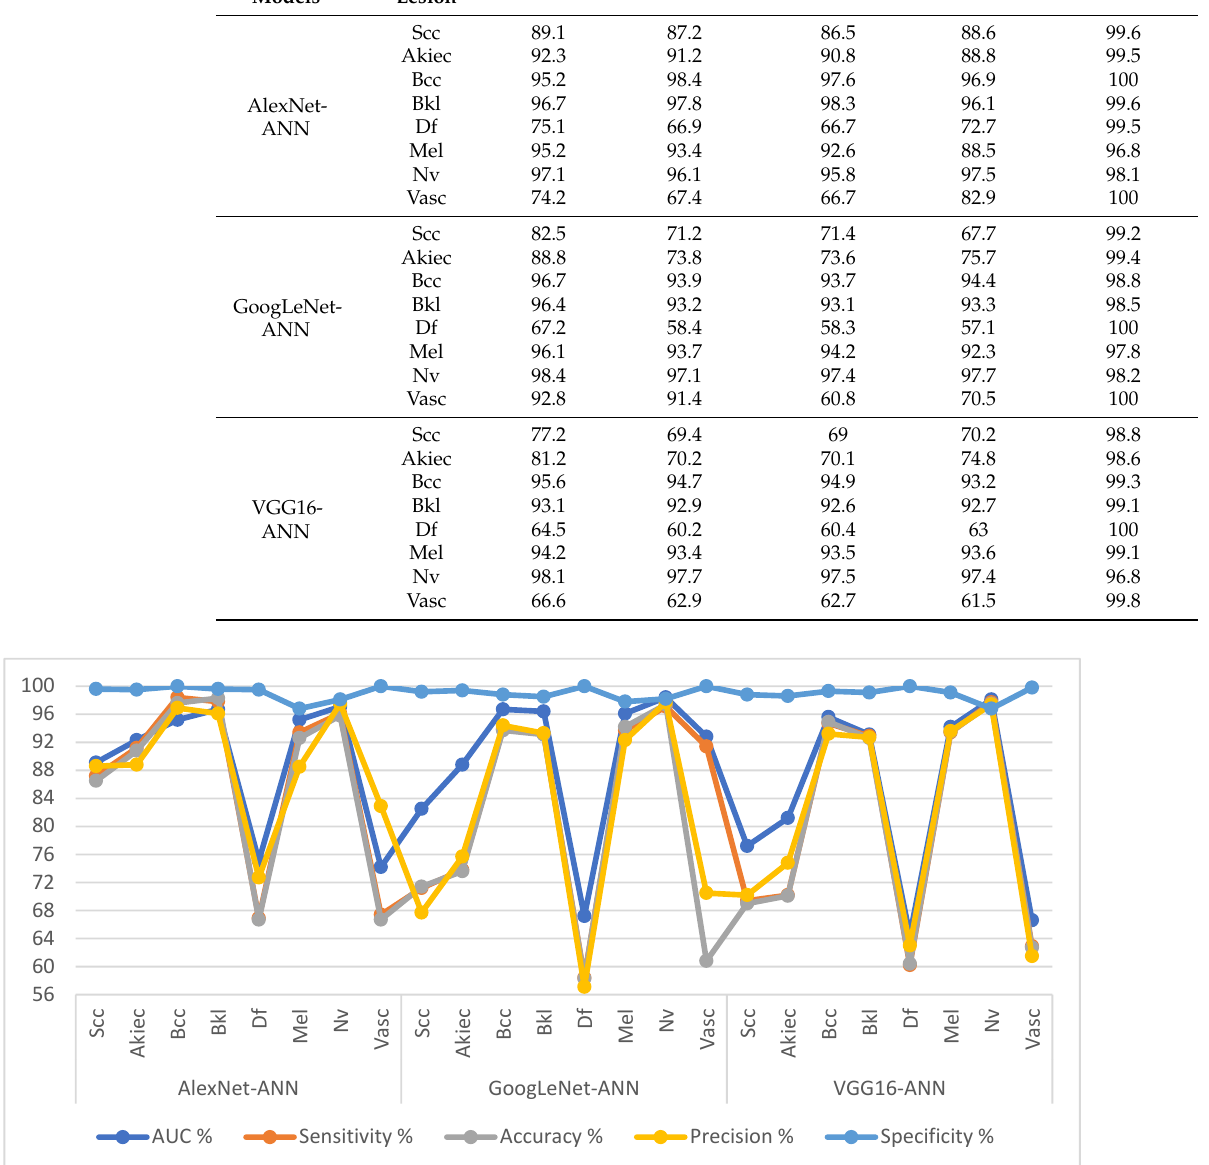
Figure 9. Display Performance results of CNN-ANN hybrid models based on ROI using the GAC method for early diagnosis and distinction of skin cancer and other skin lesions.